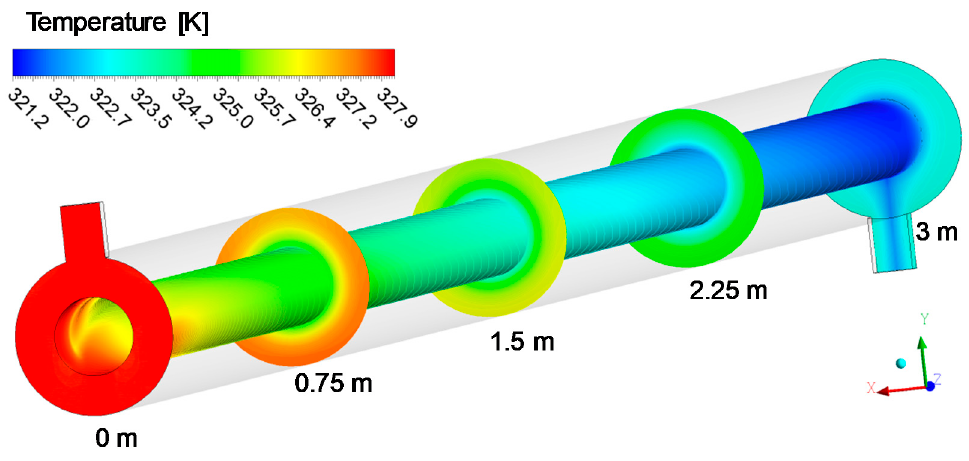
Figure 10. Temperature field inside the shell and tube module for T 0 = 55 °C (Case 6).